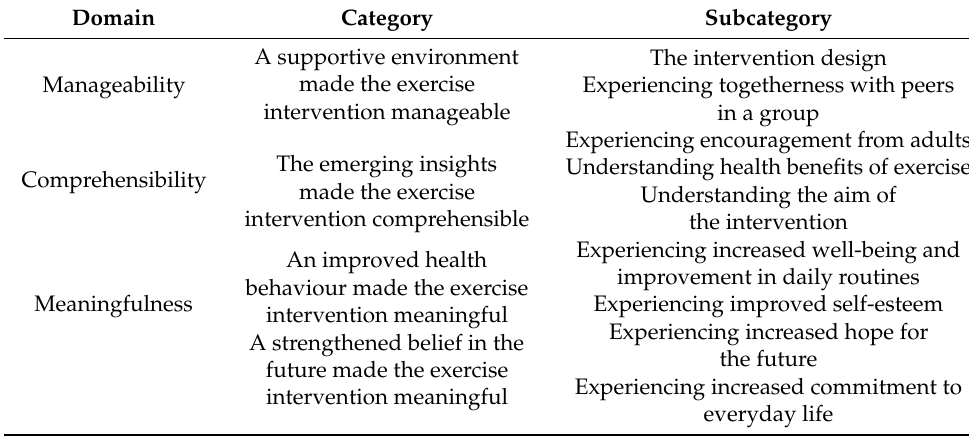
Table 2. Overview of domains, categories, and subcategories that emerged in the qualitative content analysis of adolescents’ long-term experiences of manageability, comprehensibility, and meaningful- ness of a group-based exercise intervention for